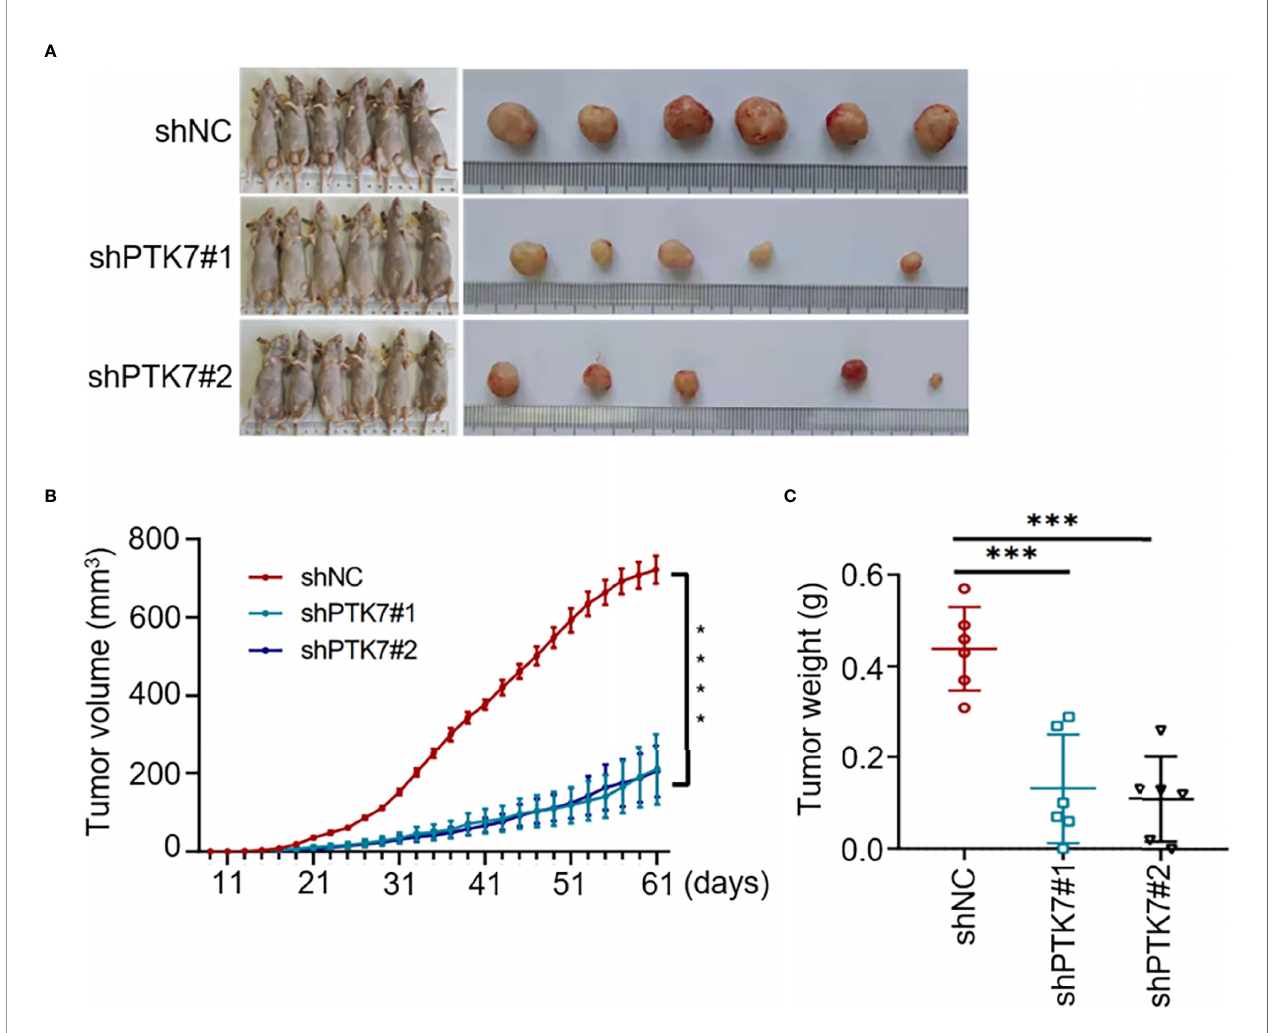
FIGURE 7 | PTK7 promotes in vivo TNBC tumorigenicity. (A) Nude mice were injected into the mammary fat pad with shNC-, shPTK7#1- or shPTK7#2-transduced MDA-MB-468 cells at 5×10 5 cells per site. Mice were sacri fi ced and tumors were photographed 61 days after subcutaneous injection. (B) Tumor volume was monitored every 2 days after injection and tumor growth curve is shown. Tumor volume was calculated by the formula: V = 1/2× a (length)× b 2 (width). (C) The harvest tumor weight was shown as mean ± s.d. *** P < 0.001; **** P <